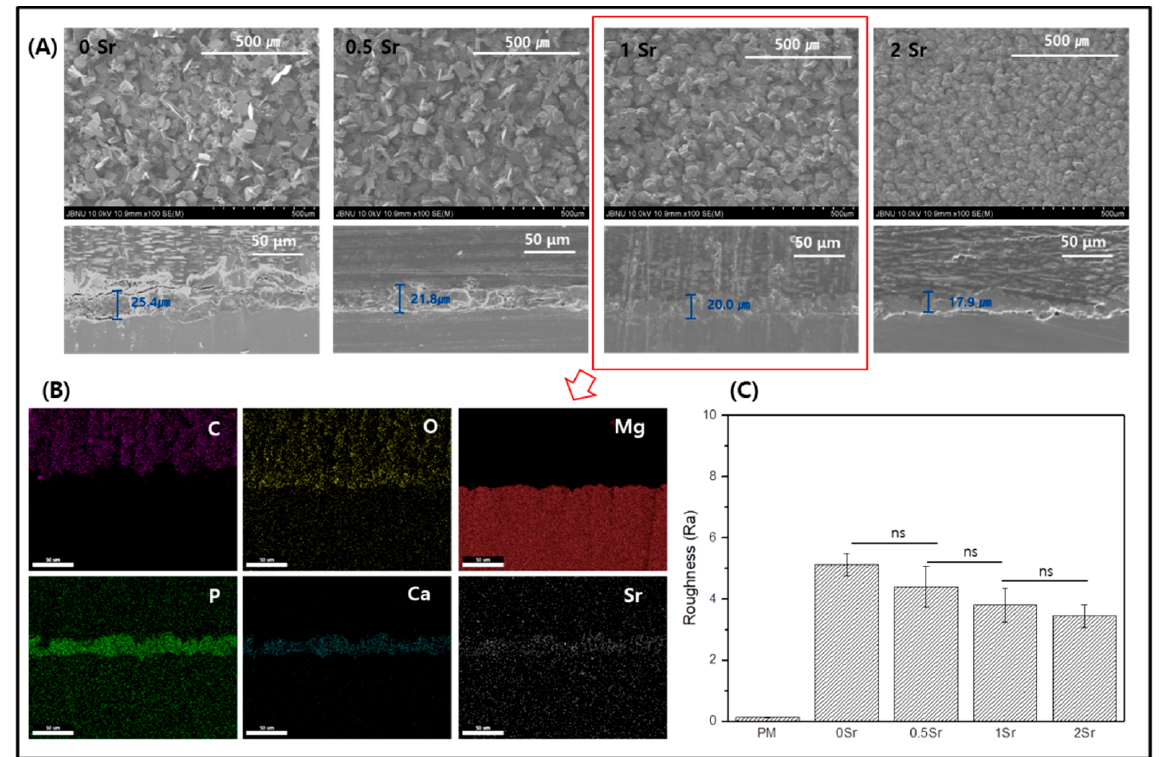
Figure 2. ( A ) Field emission scanning electron microscope (FE-SEM) image of surface and cross section, ( B ) Mapping image of cross-section of 1Sr coated Mg, and ( C ) Roughness of surface (ns, no statistical significance).